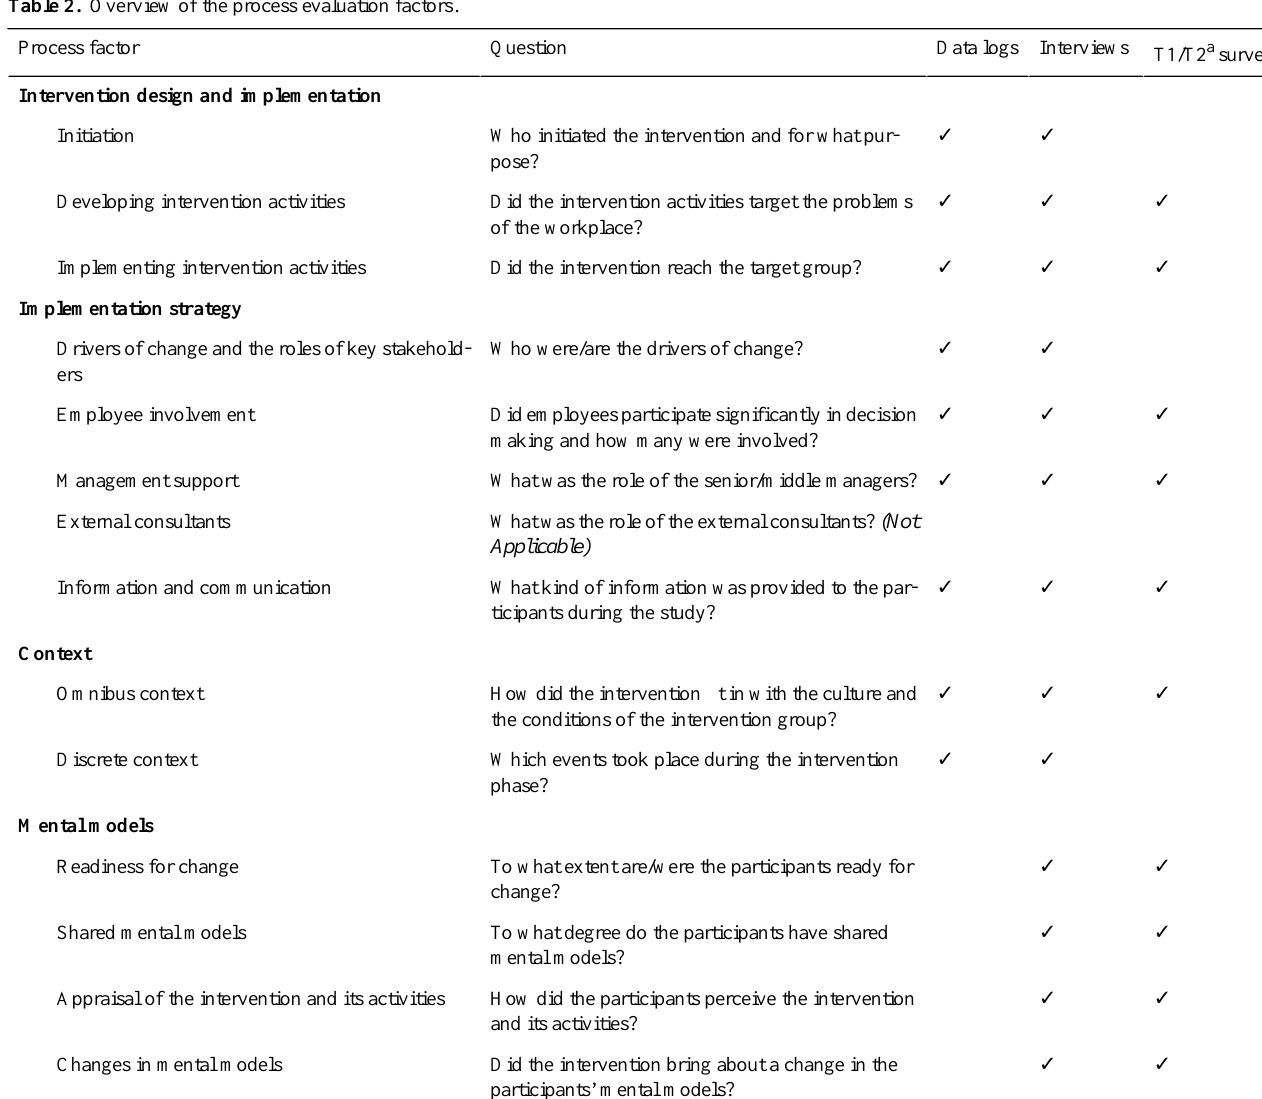
Table 2. Overview of the process evaluation